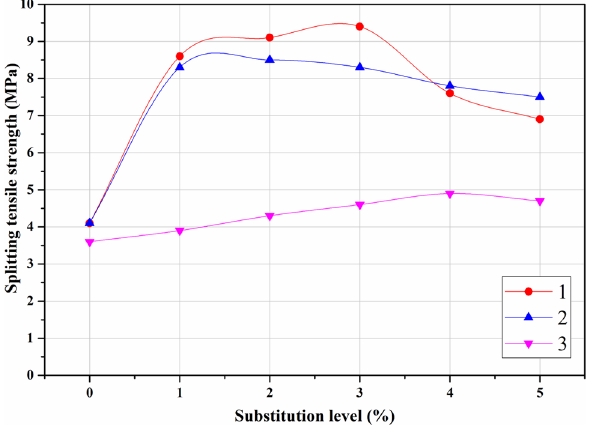
Fig. 8 Variation of 28-day splitting tensile strength of concrete with substitution level of nanoparticles: (1): nano-SiO [13]; (2): nano-fer- 2 rite [13]; (3): nano-TiO 2